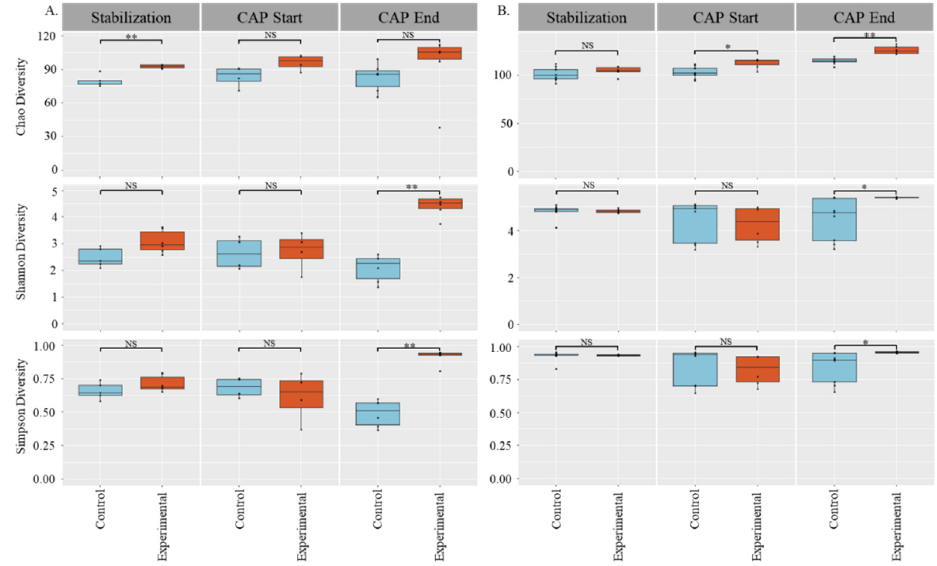
Figure 1. Alpha Diversity of Stabilization, CAP start, and CAP end phases: ( A ) C1, ( B ) C2, top: Chao diversity; middle: Shannon’s diversity; bottom: Simpson’s diversity. Significance determined by Wilcoxon Rank-Sum tests: * = p < 0.05, ** = p <